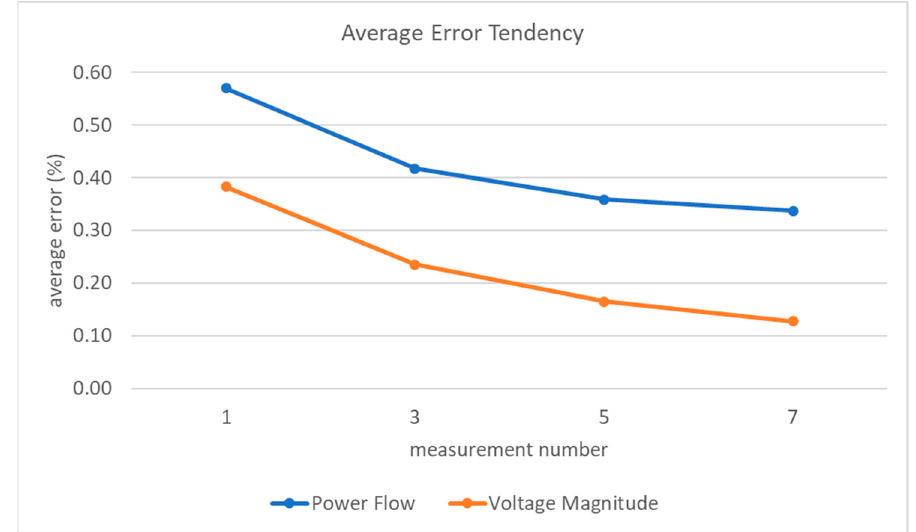
Figure 11. Influence of adding electric meters on the estimation error.